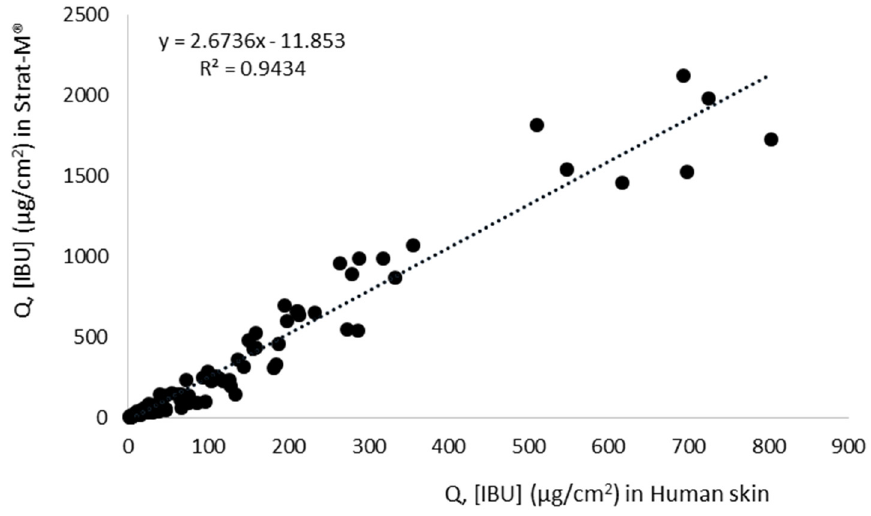
Figure 7. The correlation between human skin and Strat-M ® for all analyzed compounds, during 24 h penetration, Pearson’s test, p < 0.05.